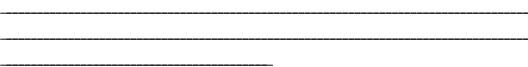
4: The following table represents six fictitious scenarios. In each one, there is a value for survival time and another for quality of life. Both for survival time and for quality of life, the value zero represents the worst possible situation (in each case, an immediate risk of death and major suffering from the disease), whereas a value of 10 represents the best possible situation (an expectation of a life of many years and no suffering caused by the disease). The other numbers represent intermediate situations.